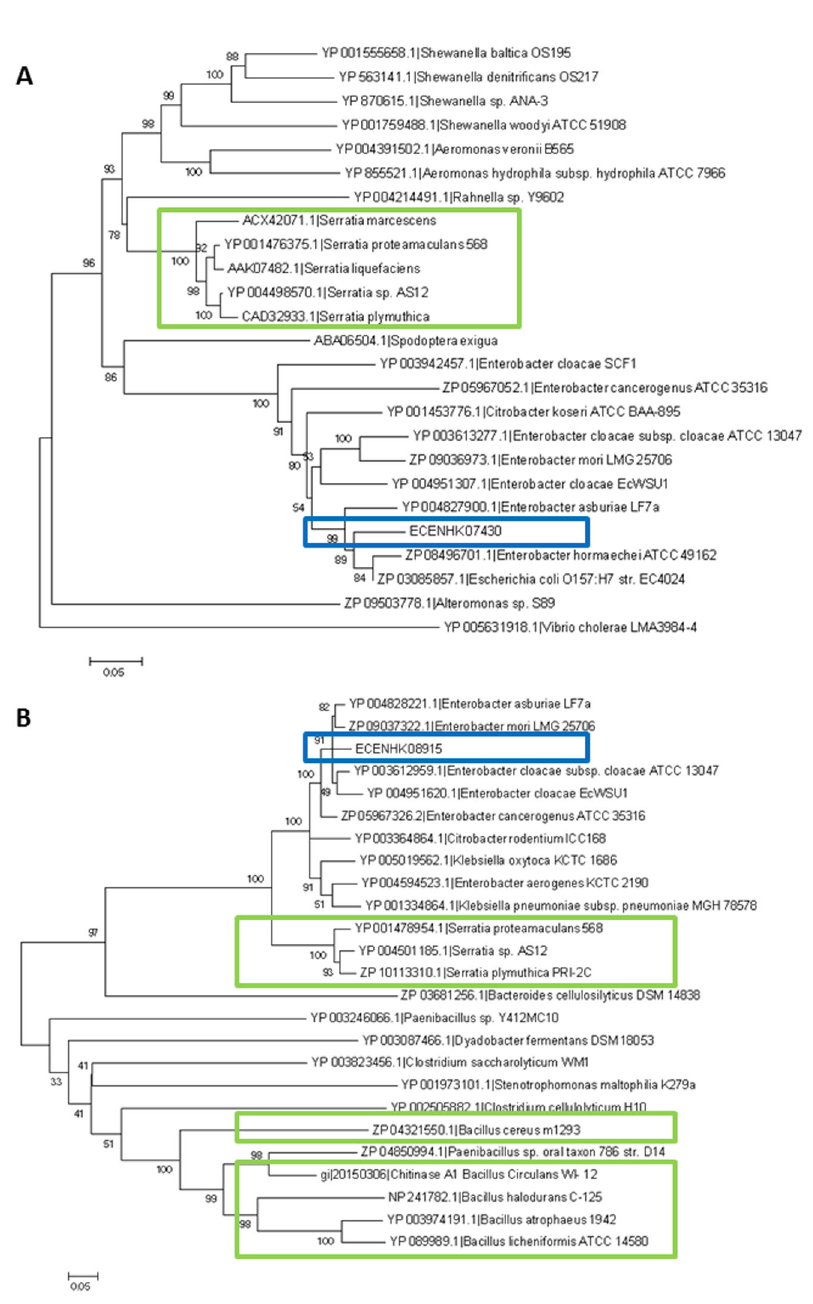
Figure 5. Phylogenetic analysis of chitinase genes. Neighbor-joining tree with bootstrap values of chitinase genes associated with (A) ECENHK_07430 and (B) ECENHK_08915 constructed by twenty-five representing orthologs from each species using MEGA5. The blue box indicates the corresponding chitinase gene of ENHKU01. Chitinases that have been functionally characterized for their antifungal activities are highlighted in green boxes [87,88,89,90,91]. doi: 10.1371/journal.pone.0074487.g005 that Bacillus spp. are well-known as plant growth-promoting rhizobacteria (PGPR), as they have antagonistic effects against other microorganisms and are used commercially as biological control agents for various fungal pathogens [65,66].